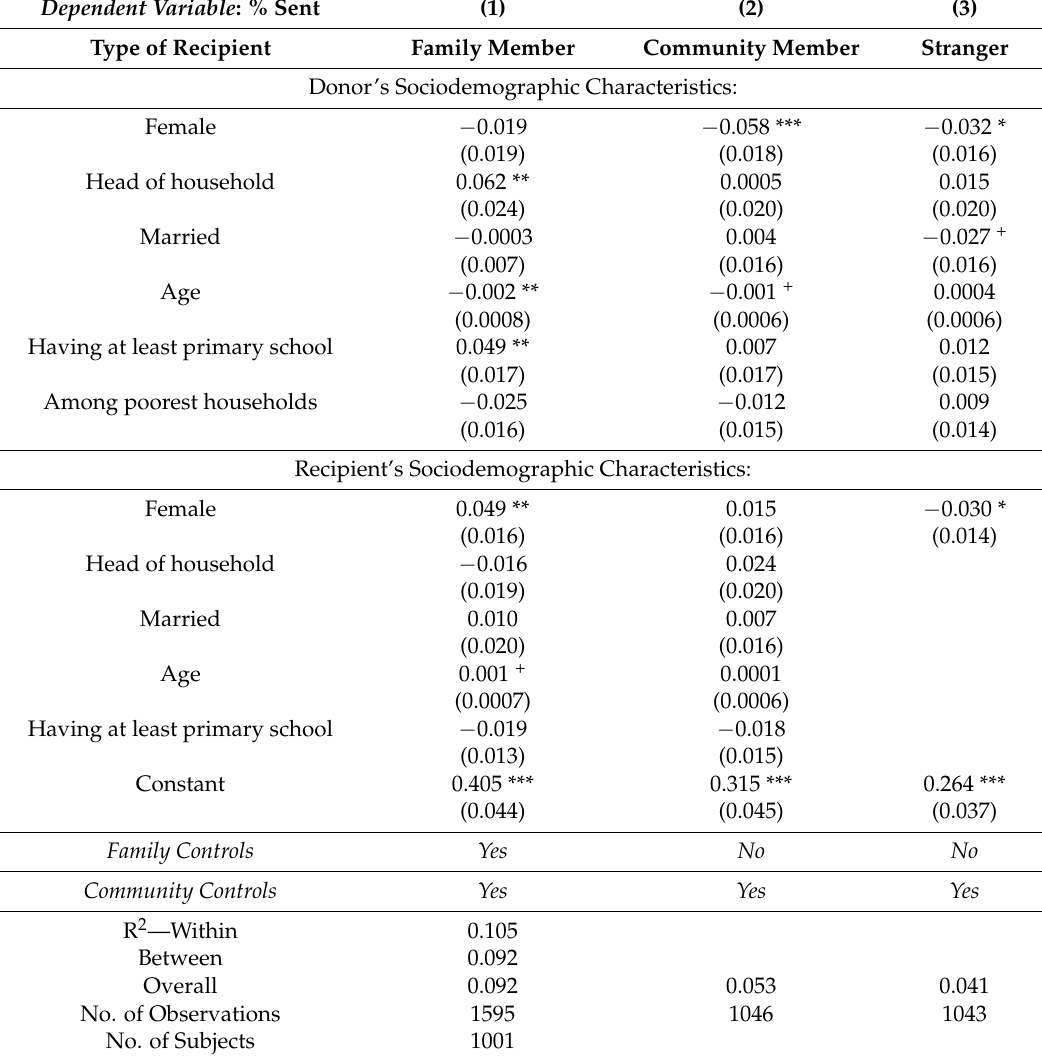
Table A2. Percentage of the Endowment Sent to the Recipient by Type of